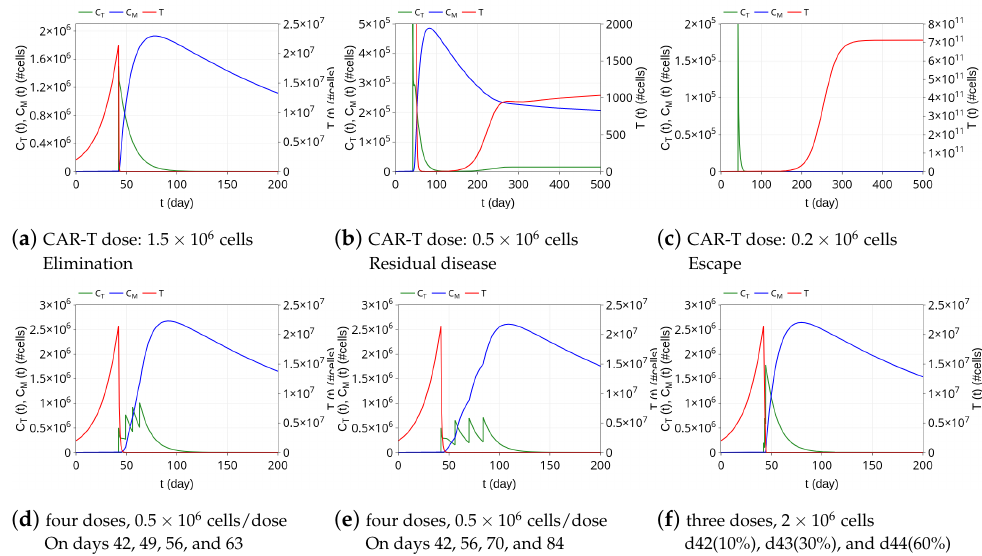
Figure 4. In silico predictions of the immunotherapy response to different CAR-T cell doses and protocols, beginning on day 42. Initial HDLM-2 tumor burden amounts to 2 10 6 cells. Top row: × ( a ) with 1.5 10 6 CAR-T cell dose, tumor elimination occurs around day 55 and approximately × 7 10 5 memory CAR-T cells remain at t = 200 days; ( b ) one third of the previous CAR-T cell dose × (0.5 10 6 cells) induces a strong decline in the tumor burden, although tumor rapidly resumes × growth. After day 250, the three cell populations change slightly over time, with a small pool of tumor cells coexisting with the effector and memory CAR-T cell populations, characterizing a residual disease response; ( c ) 0.2 10 6 CAR-T cell dose is not able to control the tumor, which escapes × and reaches the carrying capacity on day 350. The fast decay of effector CAR-T cells prevents the formation of a memory CAR-T cell population. Bottom row: the total CAR-T dose of 2 10 6 cells × is fractionated into four equal portions and administered every ( d ) 7 days or ( e ) 14 days; ( f ) the dose is fractionated into three infusions of increasing dose values over 3 days as in [54]. In all cases ( d )–( f ), the tumor is eliminated in a few days, followed by a decrease of the effector CAR-T cells. Fractionated infusions lead to the formation of memory CAR-T cells, although the quantity depends on the rest time between